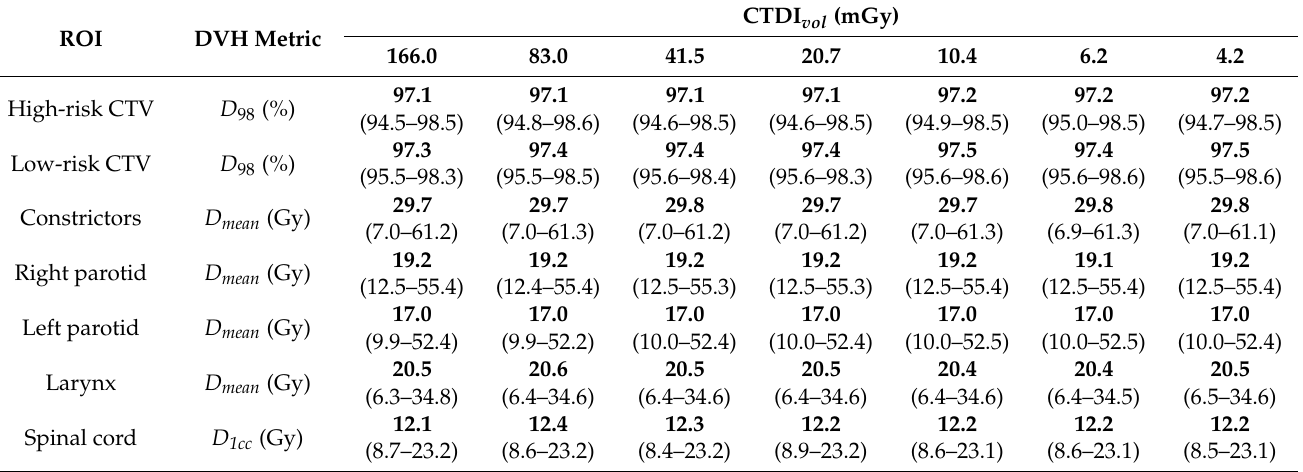
Table 2. Median (min–max) values for DVH metrics evaluated for all regions of interest (ROI) and studied